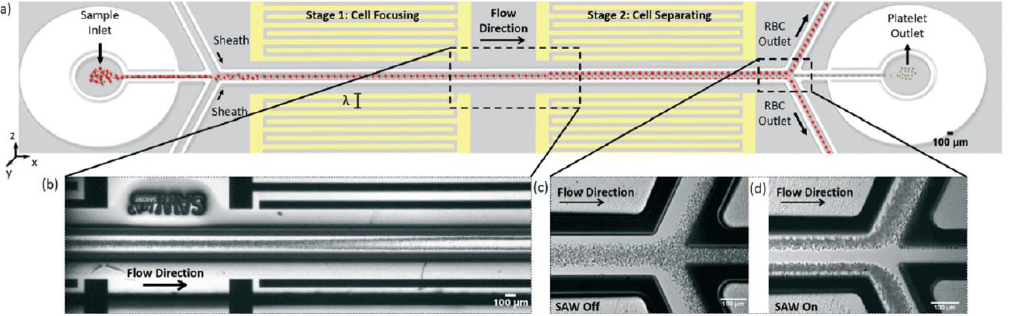
Figure 8. SAW-based device employed by Richard et al. [1] to separate blood cells. ( a ) SU-8 mi- crochannel designed for the separation, showing the approach employed for first focus and second separate RBCs from platelets; ( b ) SSAW focusing and separation of the cells; ( c ) Results with no applied SAW; ( d ) Results after applying the acoustic field.